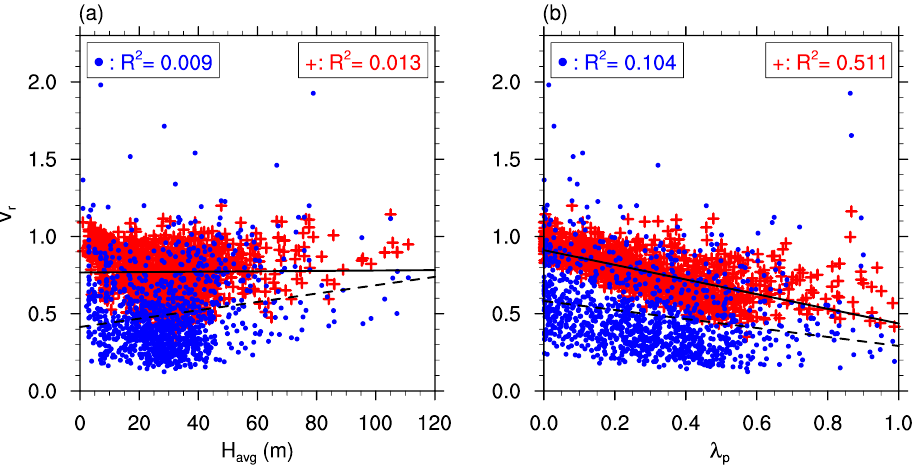
Figure 7. Scatter plot for V r and ( a ) the average building height H avg and ( b ) the plan area index λ p . Each point represents an average value inside a 100m × 100m area within the city. Blue dots represent the neutral case and red crosses represent the unstable case.